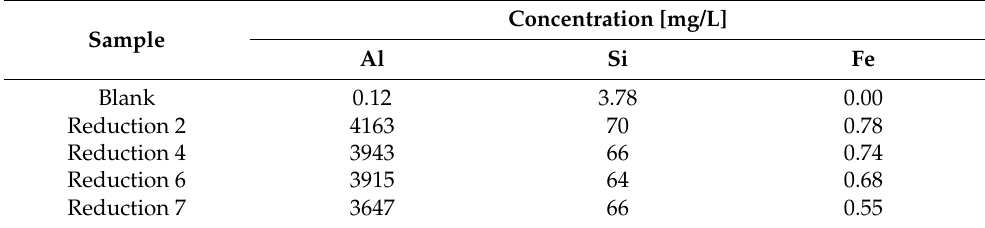
Table 6. Concentration of Al, Si and Fe in leached samples, analyzed by ICP-MS.